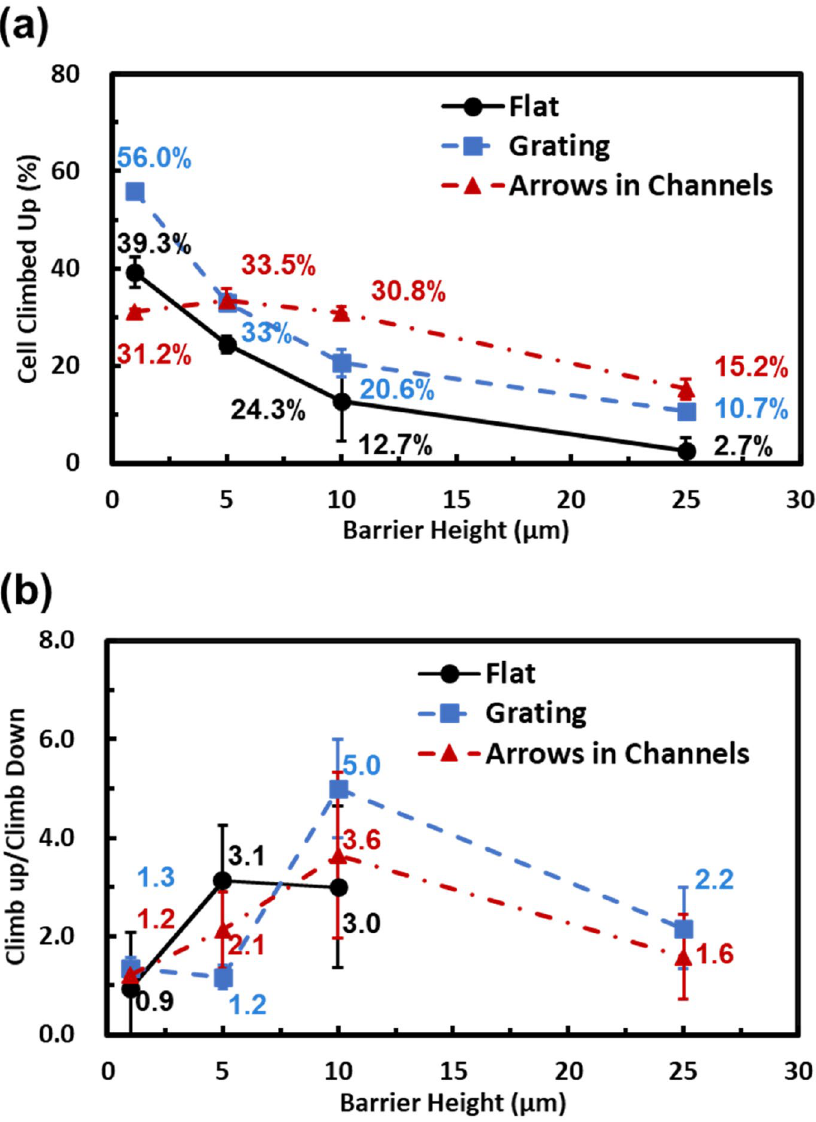
Figure 3. ( a ) Dependence of MC3T3 cells that climbed up on 1–25 µm tall barriers with grating and arrows in channels guiding patterns. ( b ) Ratio of MC3T3 cells climbed up vs. down of 1–25 µm tall barriers with various guiding patterns. All the data were obtained over a 16 h time-lapse imaging